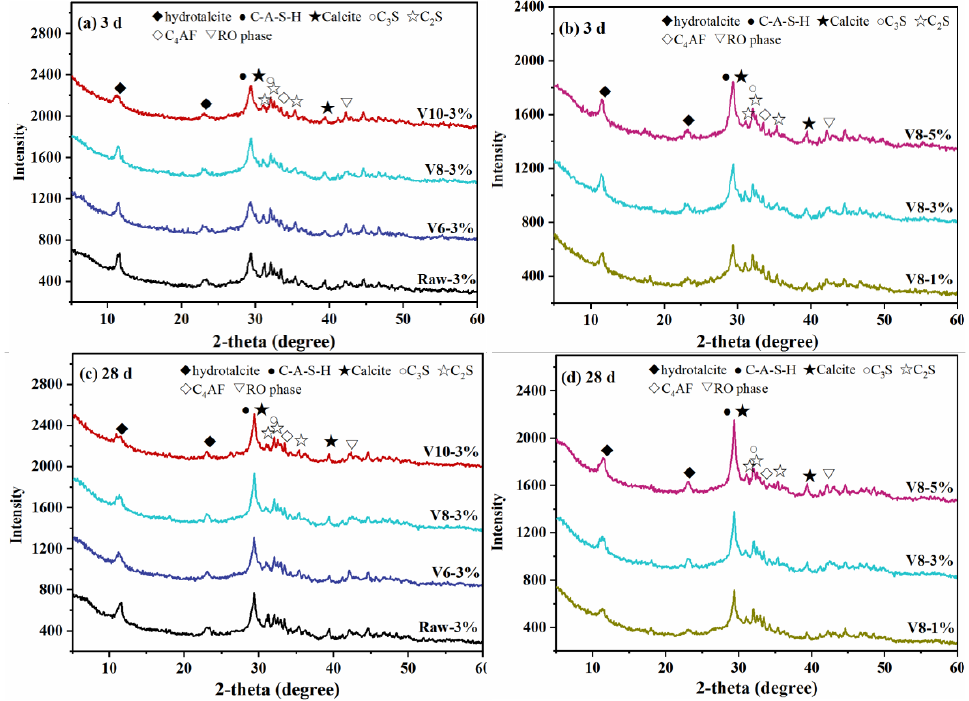
Figure 8. XRD of hardened specimens at 3 d and 28 d. Table 4. The weight loss of specimens at different temperature